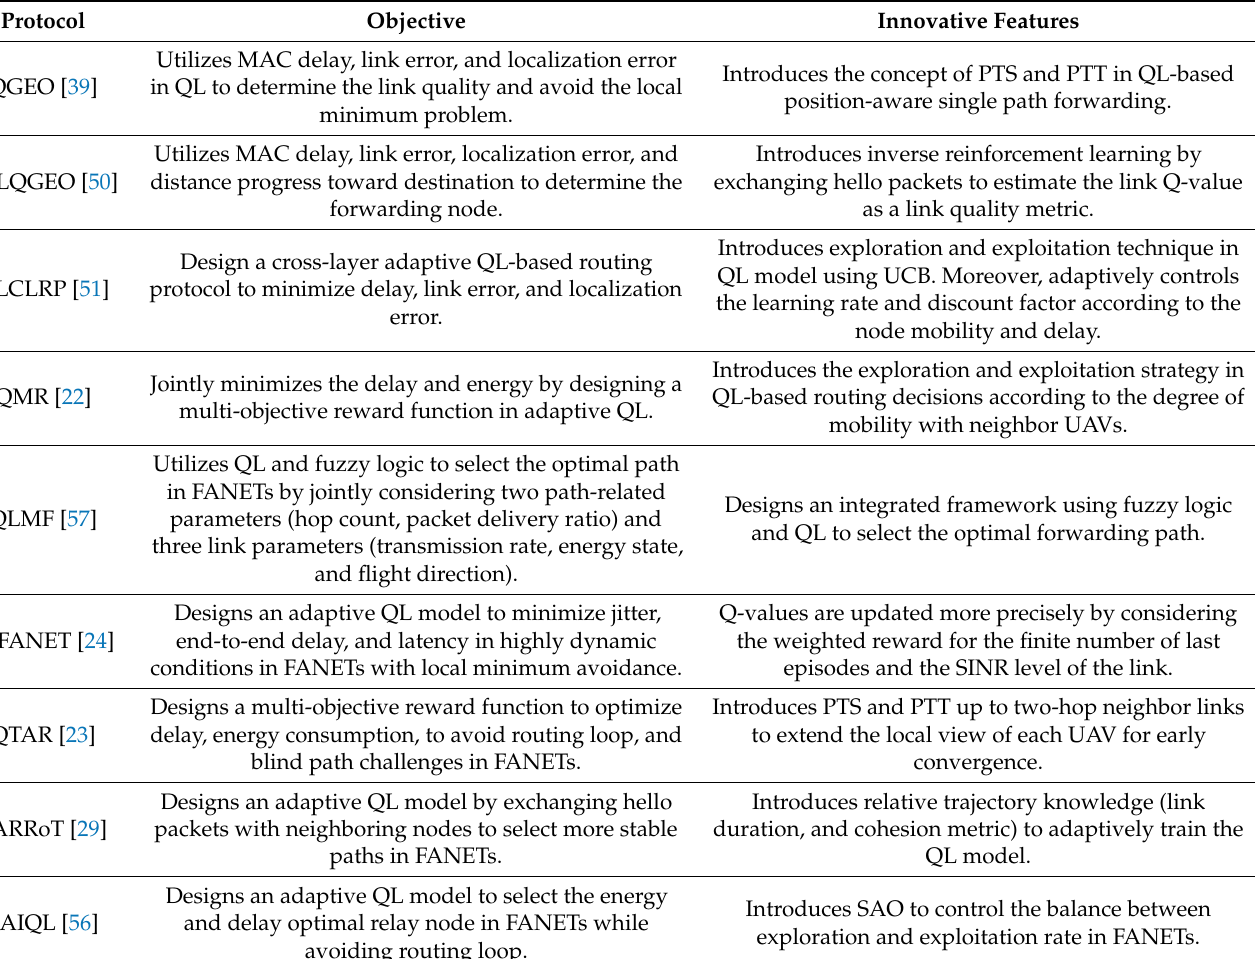
Table 6. Objective and innovative features of QL-based position-aware routing